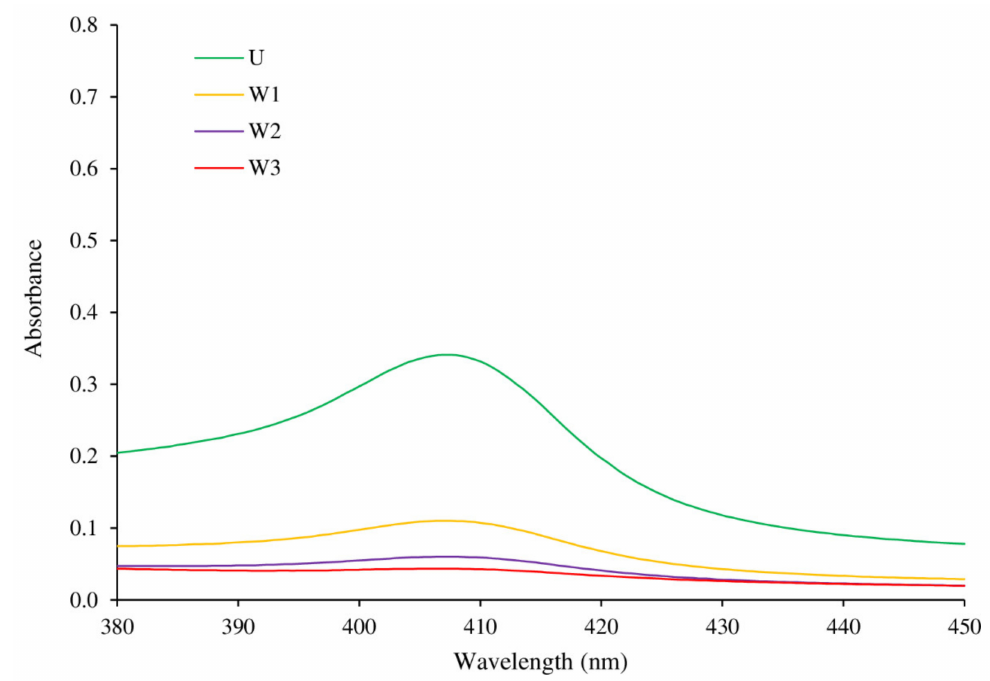
Figure 1. Changes in absorption spectra in the Soret region (380–450 nm) of myoglobin extracted from unwashed mince (U) and surimi from Indian mackerel prepared by one washing cycle (W1), two washing cycles (W2), and three washing cycles